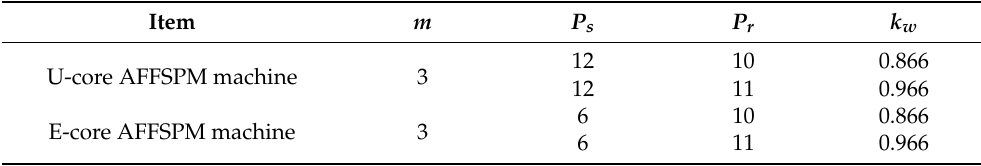
Table 2. Combination of P s and P r for U- and E-core AFFSPM machine.